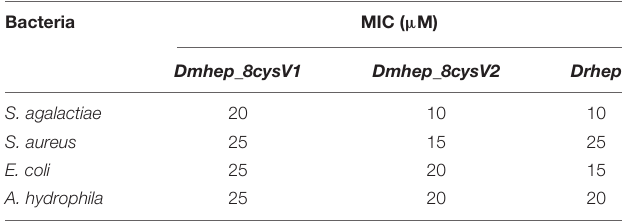
TABLE 2 | Minimum inhibitory concentration of various hepcidin